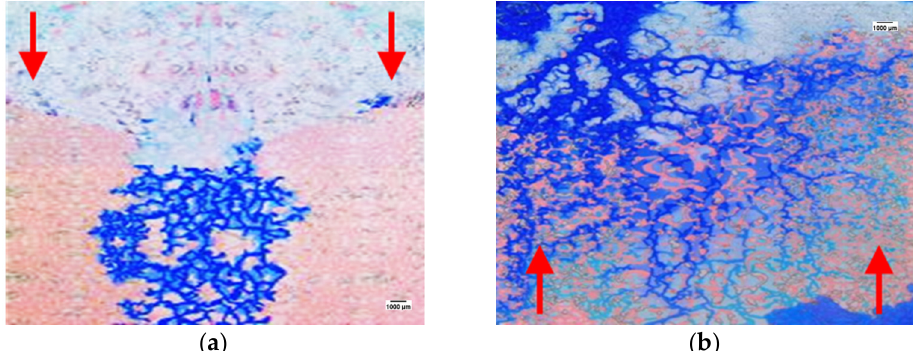
Figure 13. Process diagram of heterogeneous model gel injection and subsequent water flooding. ( a ) gel injection, ( b ) subsequent water flooding. ( a ) gel injection, ( b ) subsequent water